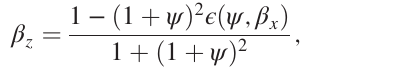
ffiffiffi p 2 . The